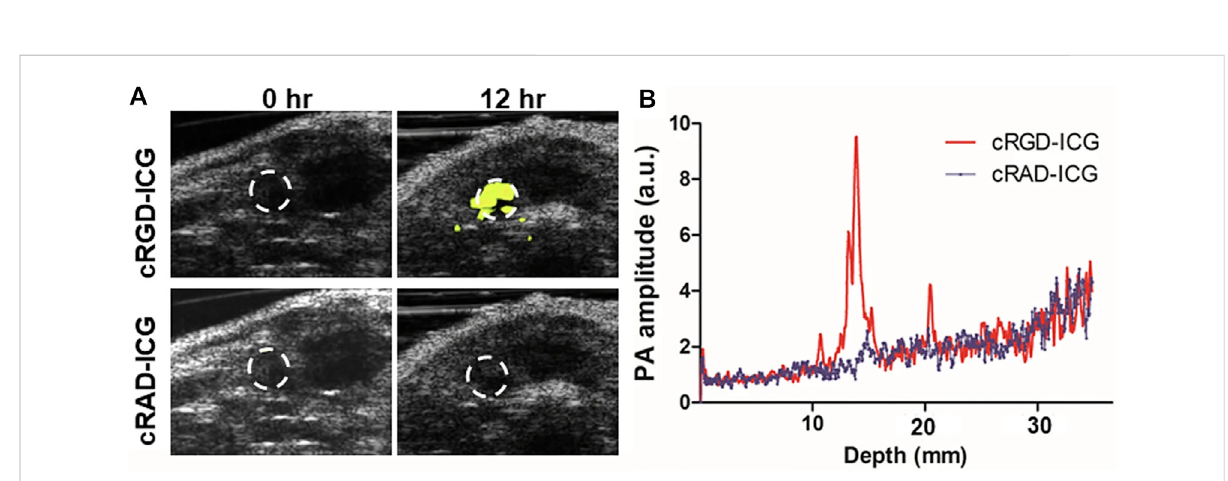
FIGURE 7 PAI of orthotopic prostate cancer with integrin α v β 3 targeted probes based on ICG (cRGD – ICG). (A) In vivo integrin α v β 3 PAI images merged with US images. (B) PAI signal varied from depths at 12 h [reproduced from (Qiu et al., 2020) with permission from Springer